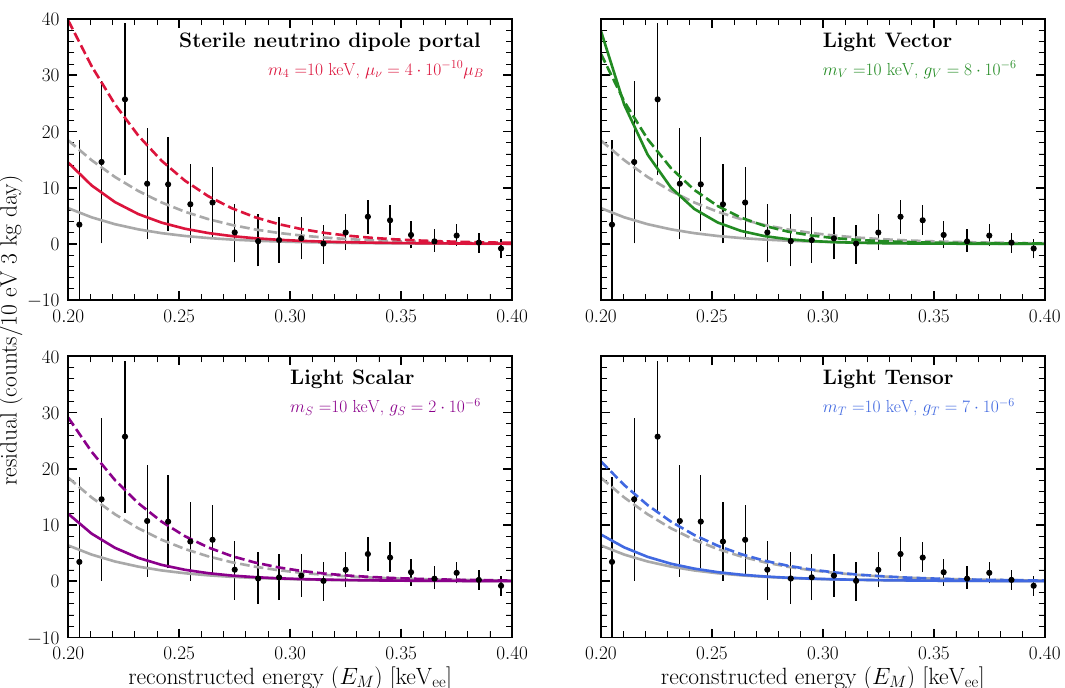
Figure 1 . Experimental data from the Dresden-II reactor obtained during 96.4 days exposure time using the NNC-1701 germanium detector. CE ν NS data follow from residual counts after the subtraction of the best-fit background components [65]. The spectral rates of signal events are also shown, for the SM prediction obtained with the modified Lindhard QF [see eq. (3.3)] (gray curves, solid for q = 0 and dashed for q = − 20 × 10 − 5 , in both cases k = 0 . 157 ) and for various new physics scenarios, with same assumptions on the